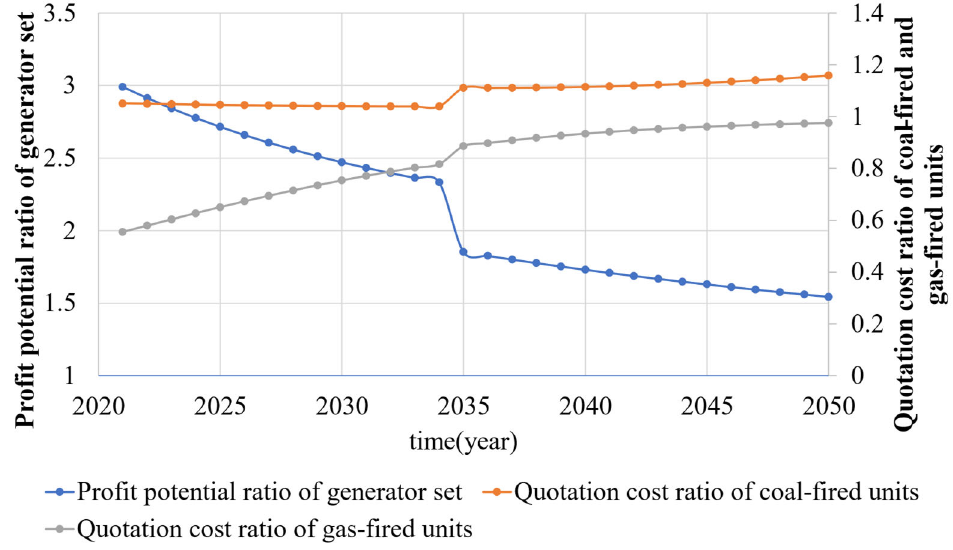
Figure 5. Profit status of thermal power units on the generation side under the basic scenario.